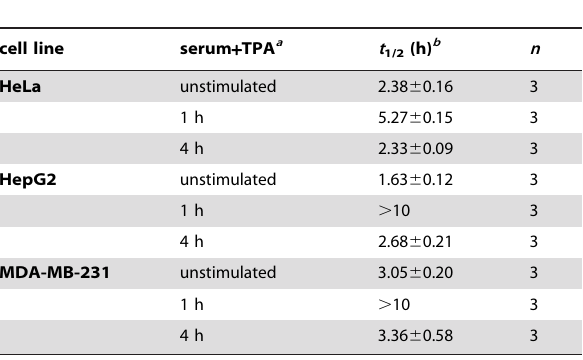
Table 1. PIM1 mRNA decay kinetics during mitogenic stimulation of cancer cell